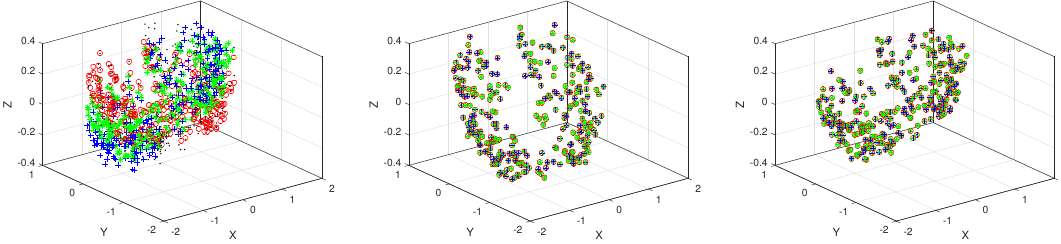
Figure 13. Registration results obtained from the application of group-wise rivals on a specific example generated from 3D COPD data. Initial unregistered point sets (first column) and the results of JRMPC (second column) and TMM (third column).